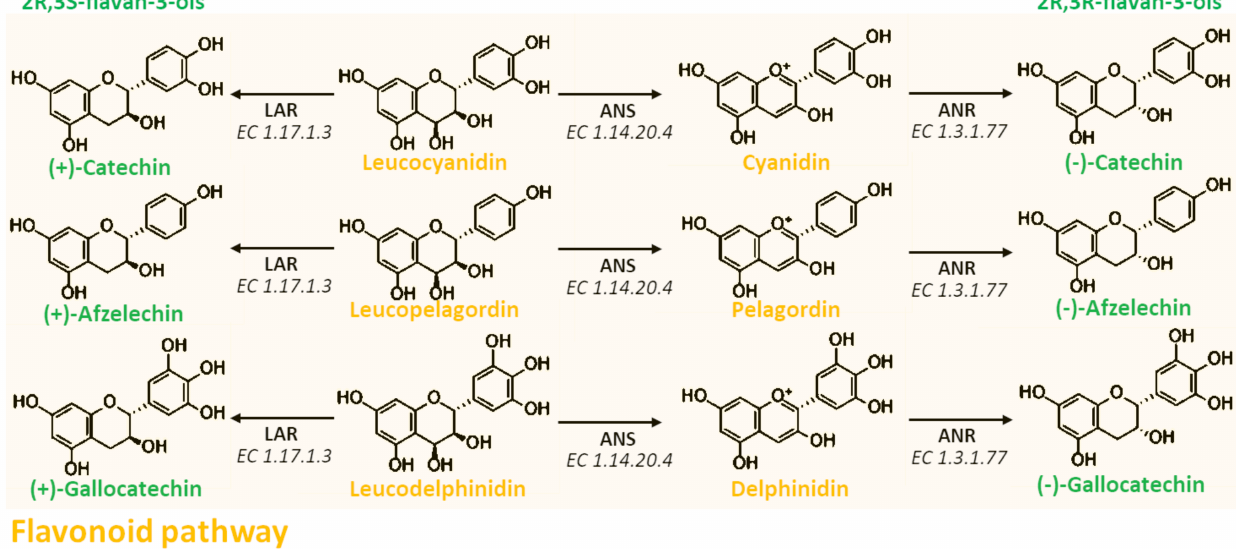
Figure 6. Biosynthetic reactions leading to the formation of 2R,3S-flavan3-ols or 2R,3R-flavan3-ols from the respective leu-